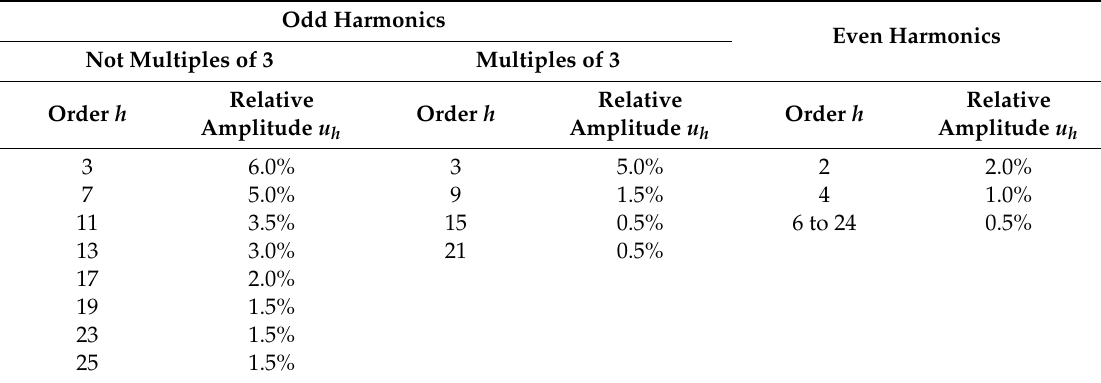
Table 1. Values of the harmonic limits at the supply terminals for orders up to 25 th.